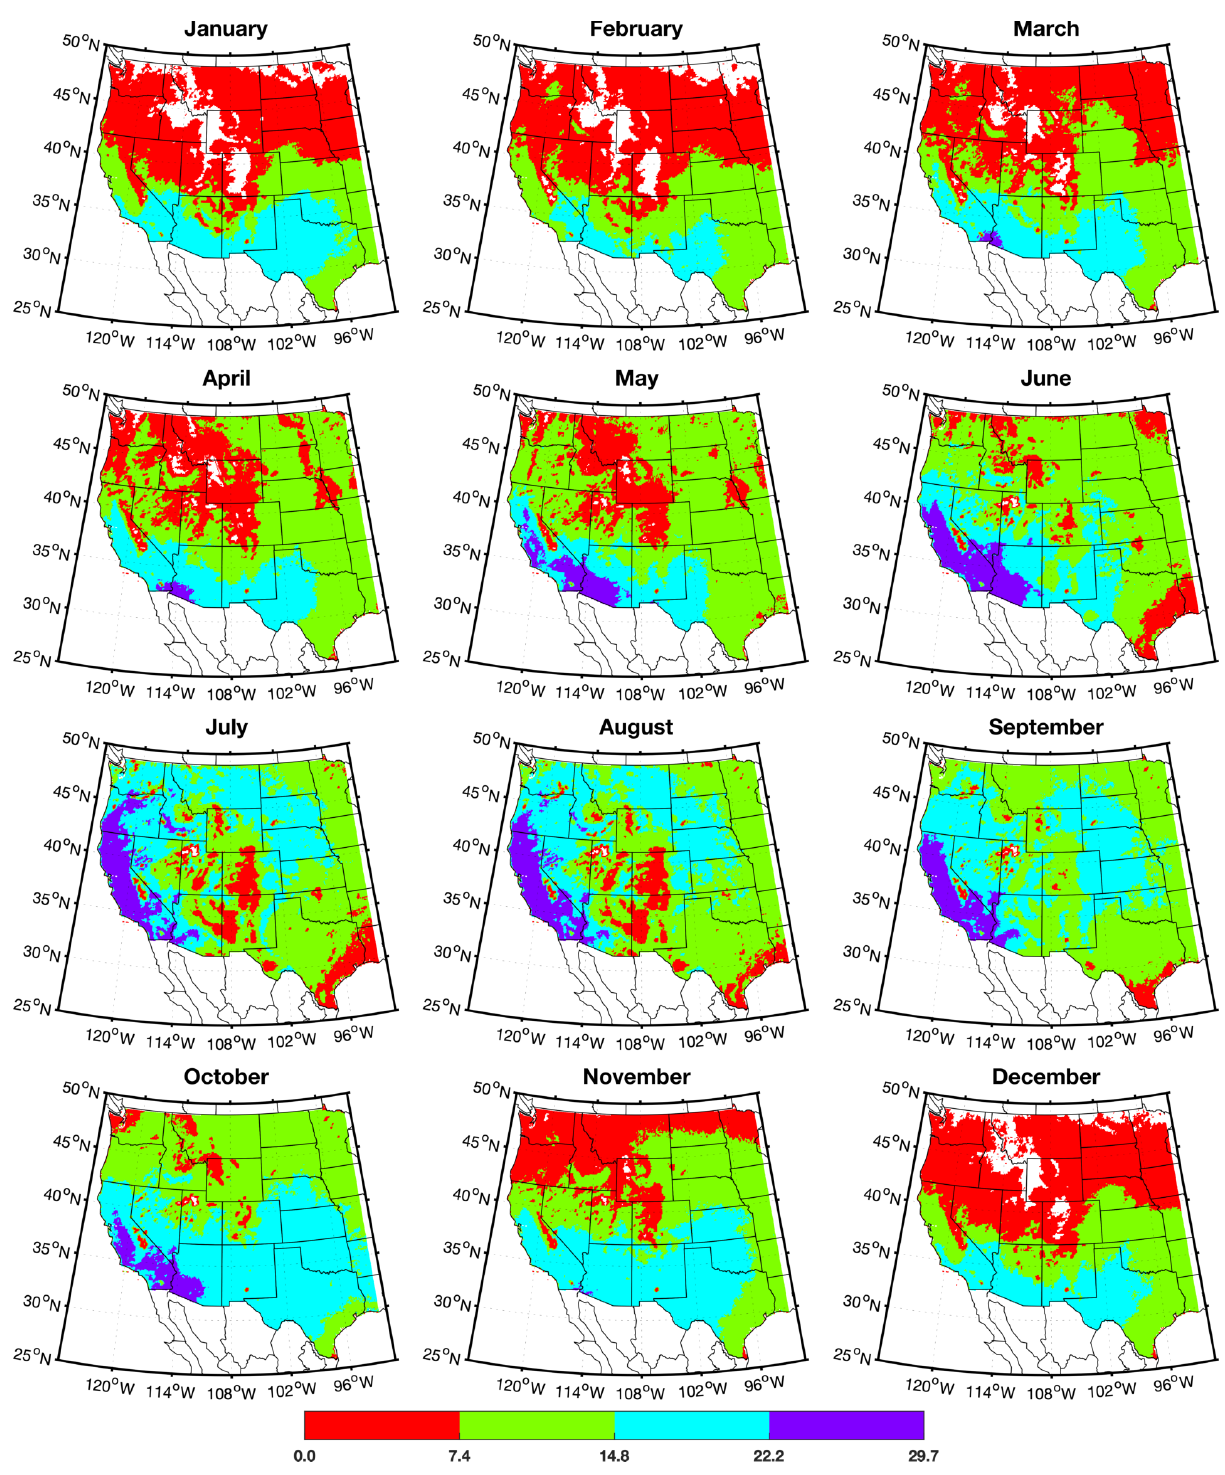
Figure 3. Long-term mean monthly distribution of the number of MODIS DB AOD retrieval per 0.1 ◦ × 0.1 ◦ averaged